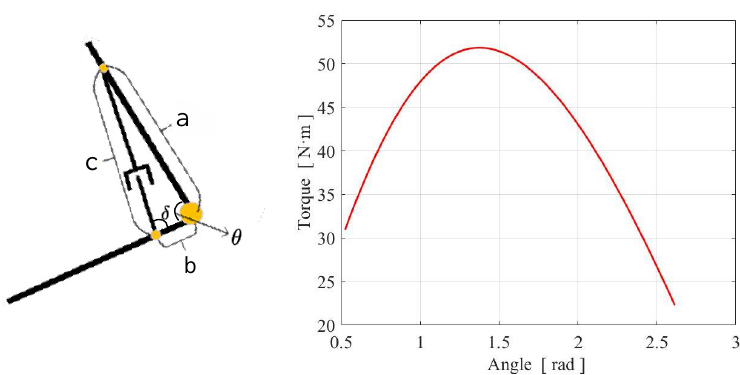
Figure 4. Kinematic analysis of the relationship between elbow joint angle and